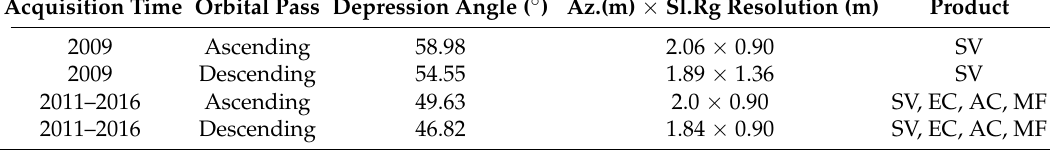
Table 1. Specifications of TerraSAR-X and TanDEM-X stripmap mode datasets used for interferometric (InSAR) processing and intensity offset tracking (SV: Surface Velocity, EC: Elevation Change, AC: Area Change, MF: Mass Flux). The acquisition dates of the TerraSAR-X/TanDEM-X images used for deriving surface velocity, for generating TanDEM-X DEMs and for mapping glacier fronts are listed in Tables S1 and S2 in the supplementary